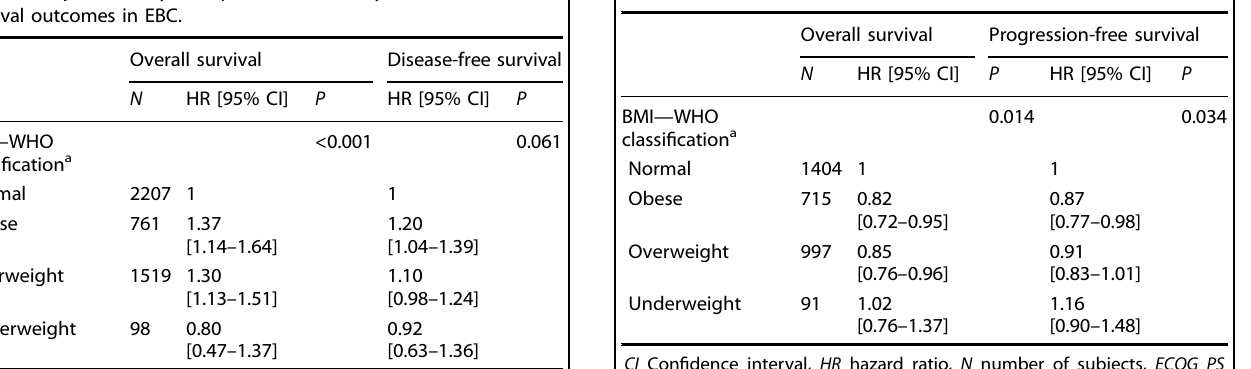
Table 2. Adjusted analysis of pretreatment body mass index with survival outcomes in